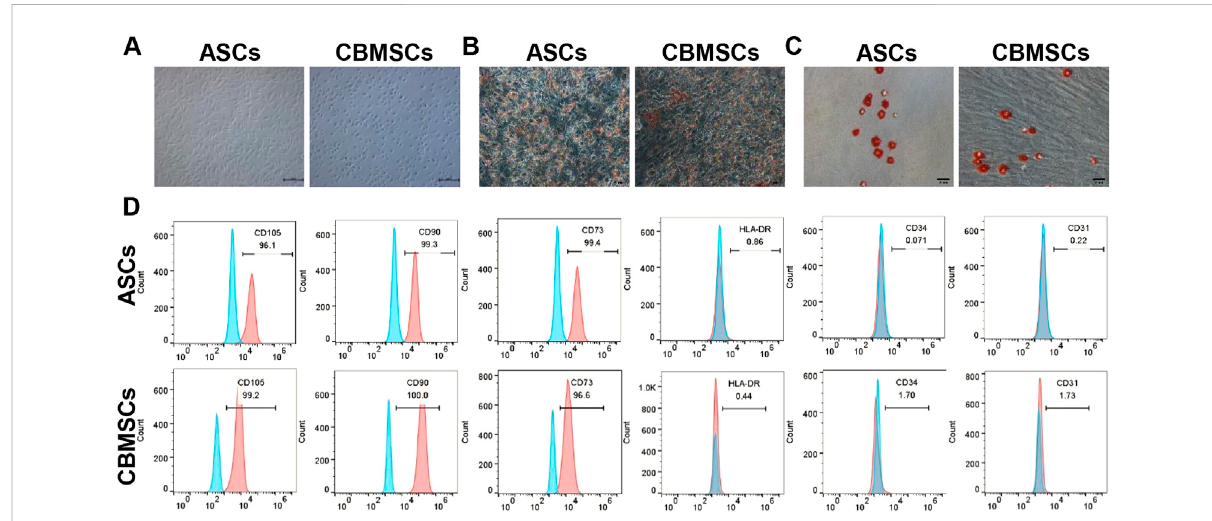
FIGURE 1 Identi fi cation of CBMSCs and ASCs. (A) Morphology of CBMSCs and ASCs. (B) Red-O staining of CBMSCs and ASCs after adipogenic induction for 21 days. (C) Alizarin Red staining of CBMSCs and ASCs after osteogenic induction for 14 days. (D) Surface markers (CD105, CD90, CD73, CD45, and CD31) of CBMSCs and ASCs were identi fi ed by fl ow cytometry.